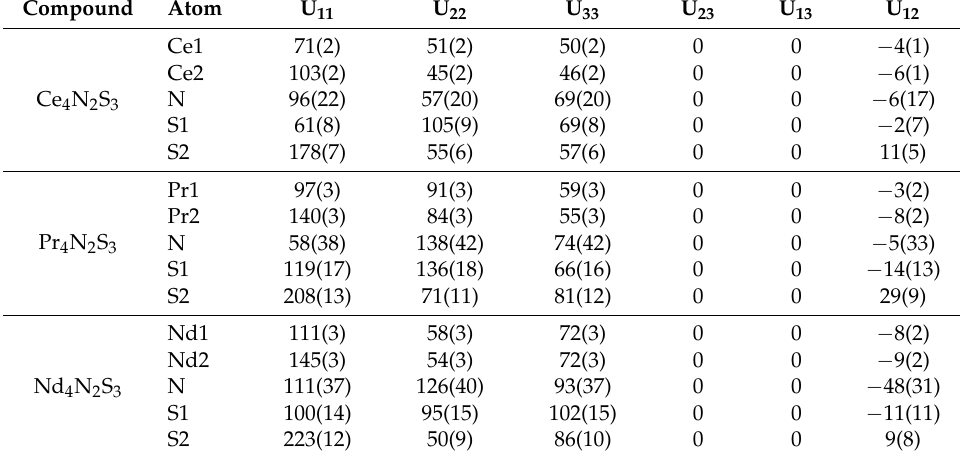
Table 3. Anisotropic displacement parameters ( U ij 1 /pm 2 ) for the three members of the Ln 4 N 2 S 3 series ( Ln = Ce–Nd).